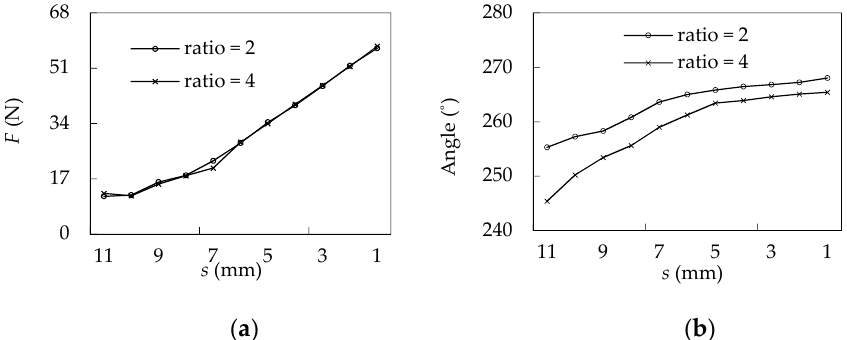
Figure 8. The EF versus s (in the non-centerline of the PM slot, L = 0.1 mm): ( a ) the amplitude; ( b ) the phase.